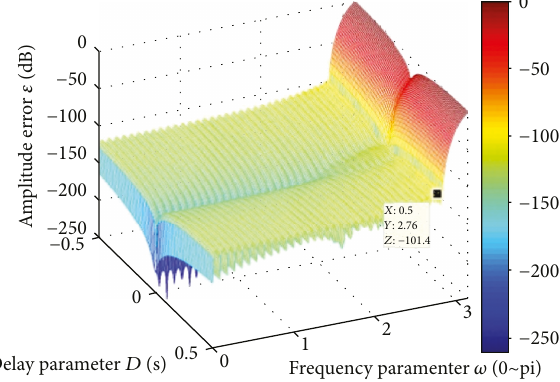
Figure 4: Error with weight function by (39).